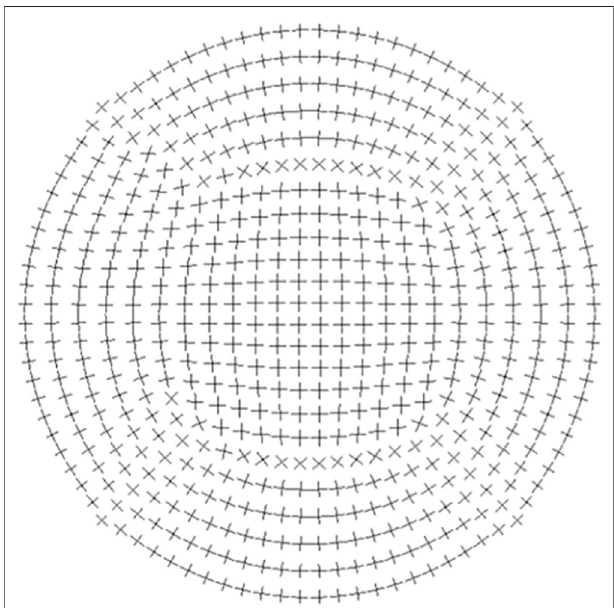
FIGURE 7 | Sketch of fi bril orientation adopted from (Pandol fi , 2020). The cornea is composed of bundles of collagen fi brils oriented in orthotropic manner.